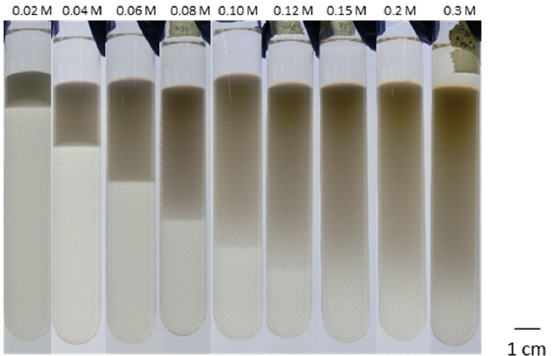
Figure 1. Formation of precipitated zone in a test tube. [NaCl] was fixed at 0.01 M. [AgNO 3 ] varied from 0.02 to 0.3 M, as shown in each photo. The sample was incubated at 18 ° C in the dark for 14 days.